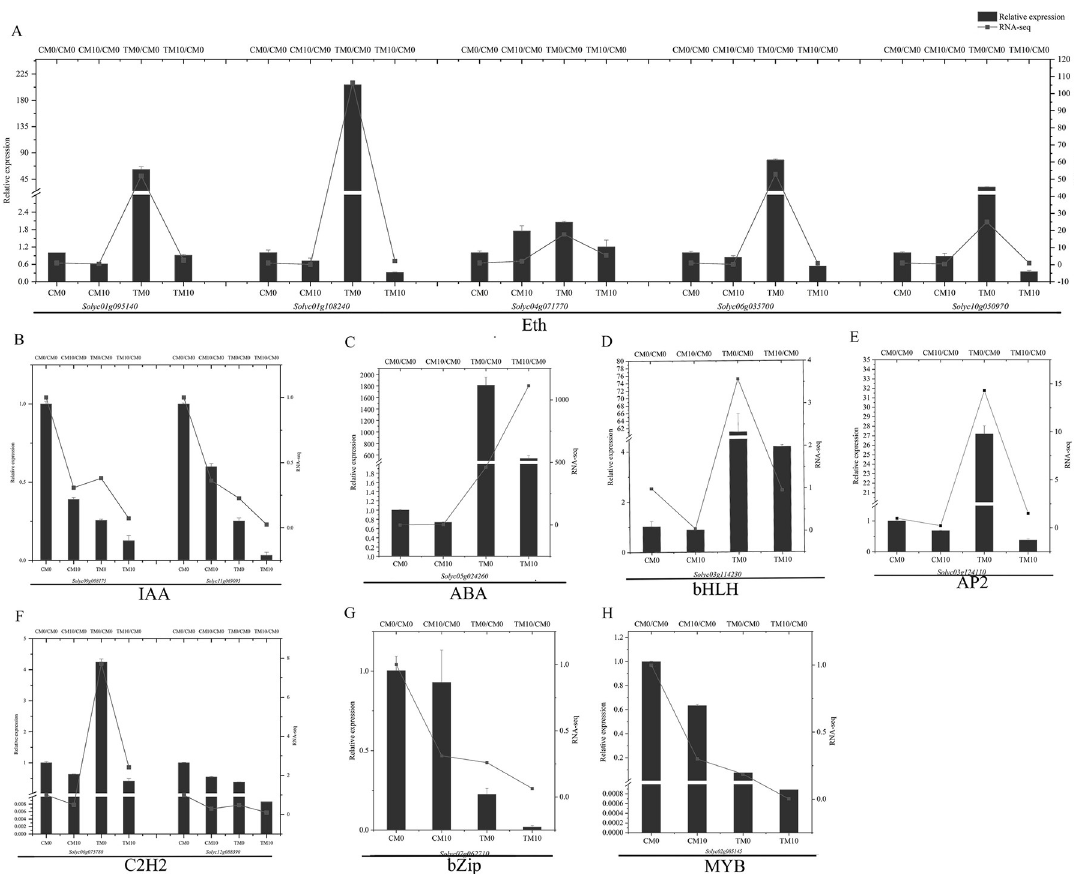
Fig 9. Accompanied by RNA-seq data, verification of phytohormones and transcription factor related DEGs by RT-qPCR with application of different concentrations of melatonin (0, 10 μ mol/L) under normal and PEG6000 simulated drought. A. Relative expression and RNA-seq data of five genes related to Eth. B. Relative expression and RNA-seq data of two genes related to IAA. C. Relative expression and RNA-seq data of gene related to ABA. D. Relative expression and RNA-seq data of gene related to bHLH. E. Relative expression and RNA-seq data of gene related to AP2. F. Relative expression and RNA-seq data of two genes related to C2H2. G. Relative expression and RNA-seq data of gene related to bZip. H. Relative expression and RNA-seq data of gene related to MYB. Error bars show the standard error between three biological replicates performed (n =